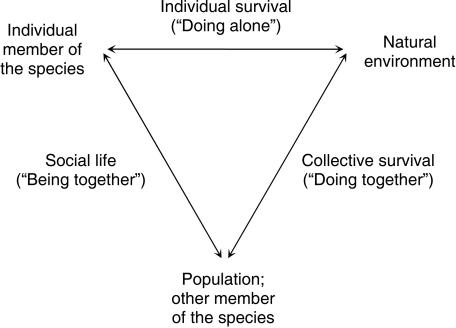
General Structure of the AnimalForm of Activity after Engeström [10].